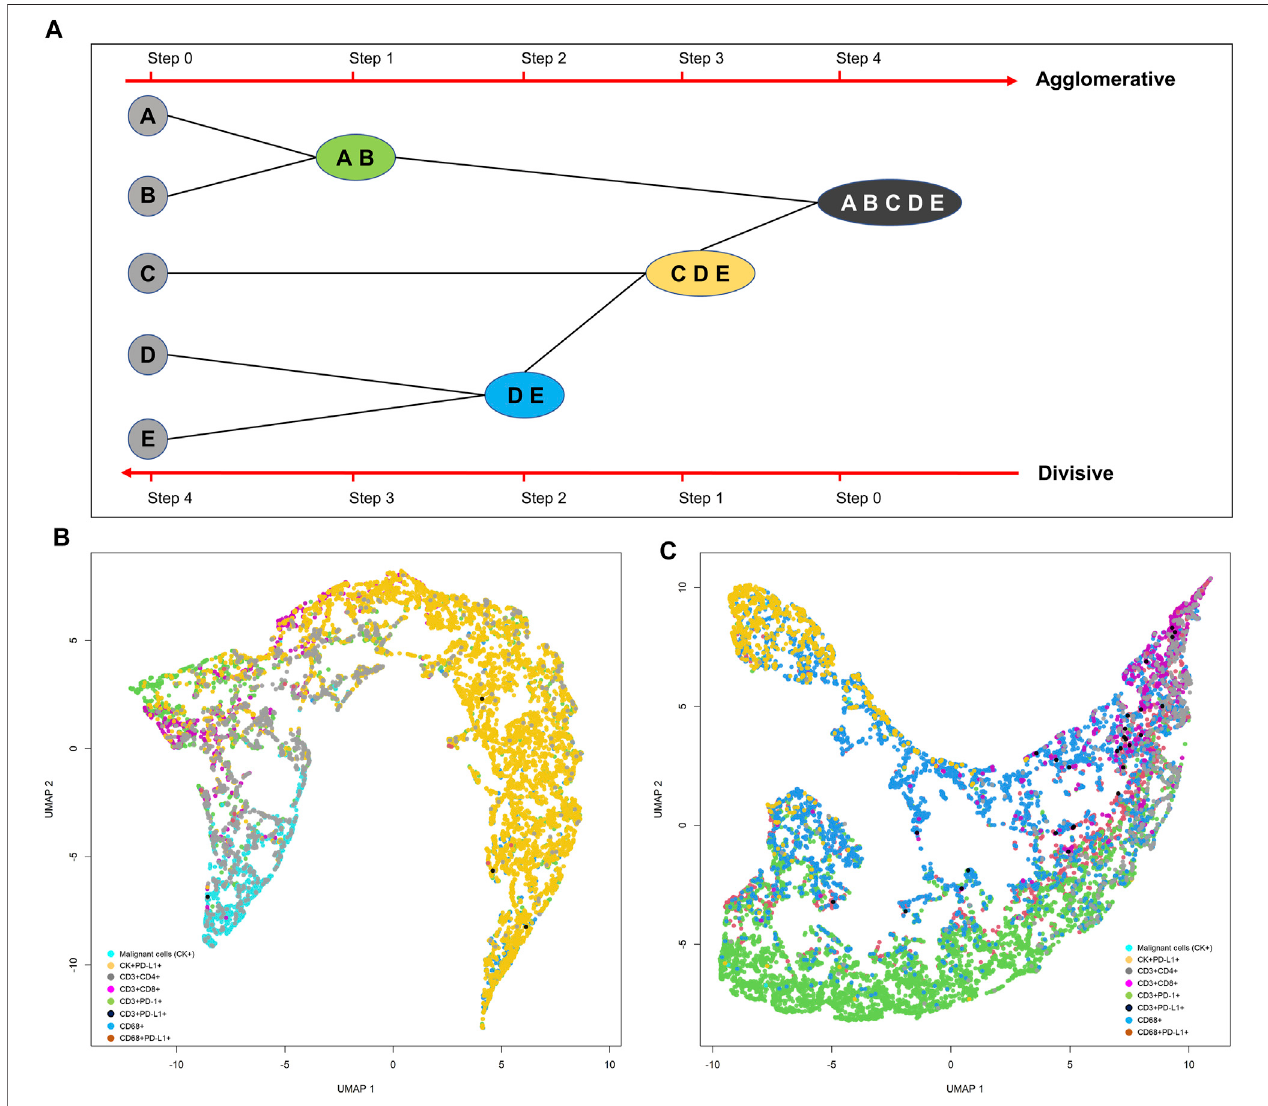
FIGURE 15 | Representative schema of hierarchical and divisive clustering to agglomerate similar objects into groups (A) . Uniform manifold approximation and projection (UMAP) showing different cell population distribution patterns extracted from two different lung adenocarcinoma cases analyzed with multiplex immuno fl uorescence against malignant cells [cytokeratin (CK)+] and CD3+, CD4+, CD8+, PD-1+, PD-L1+, and CD68+ antibodies (B, C) . The graphics B and C were generated using R studio software version 3.6.1.